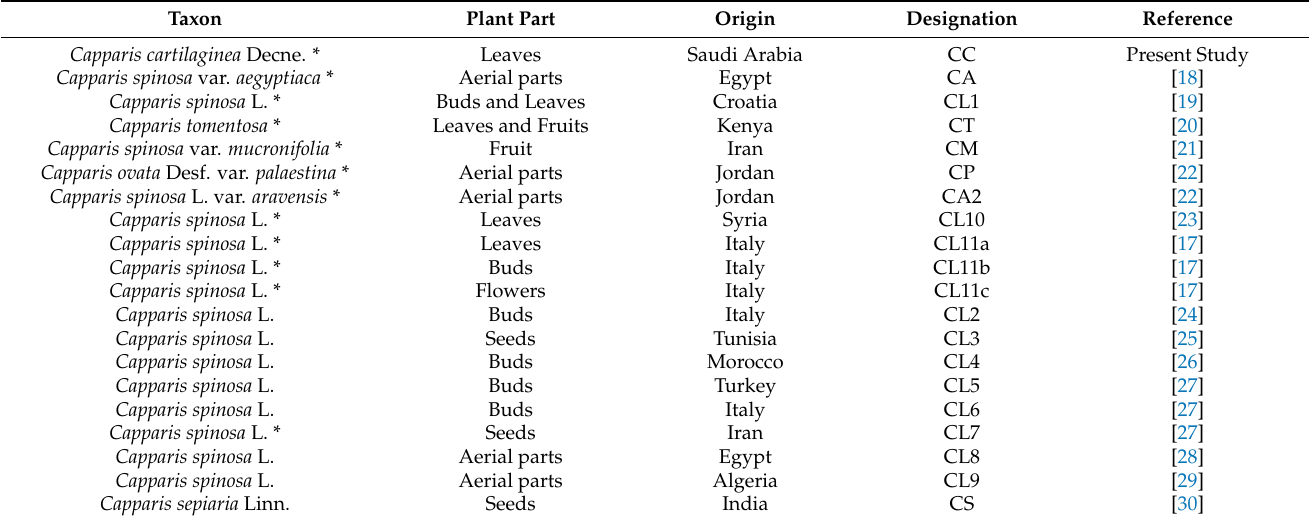
Table 2. List of essential oil samples used for statistical